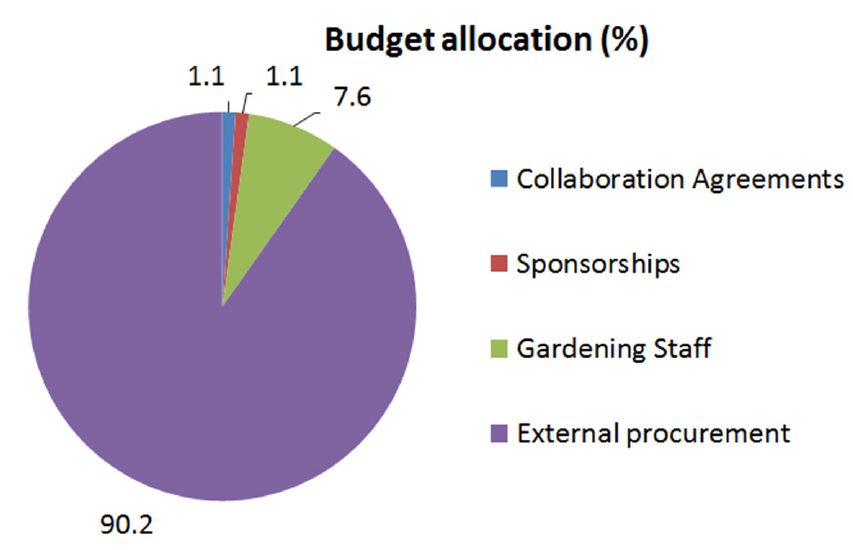
Figure 9. Average incidence in % of the different management option.